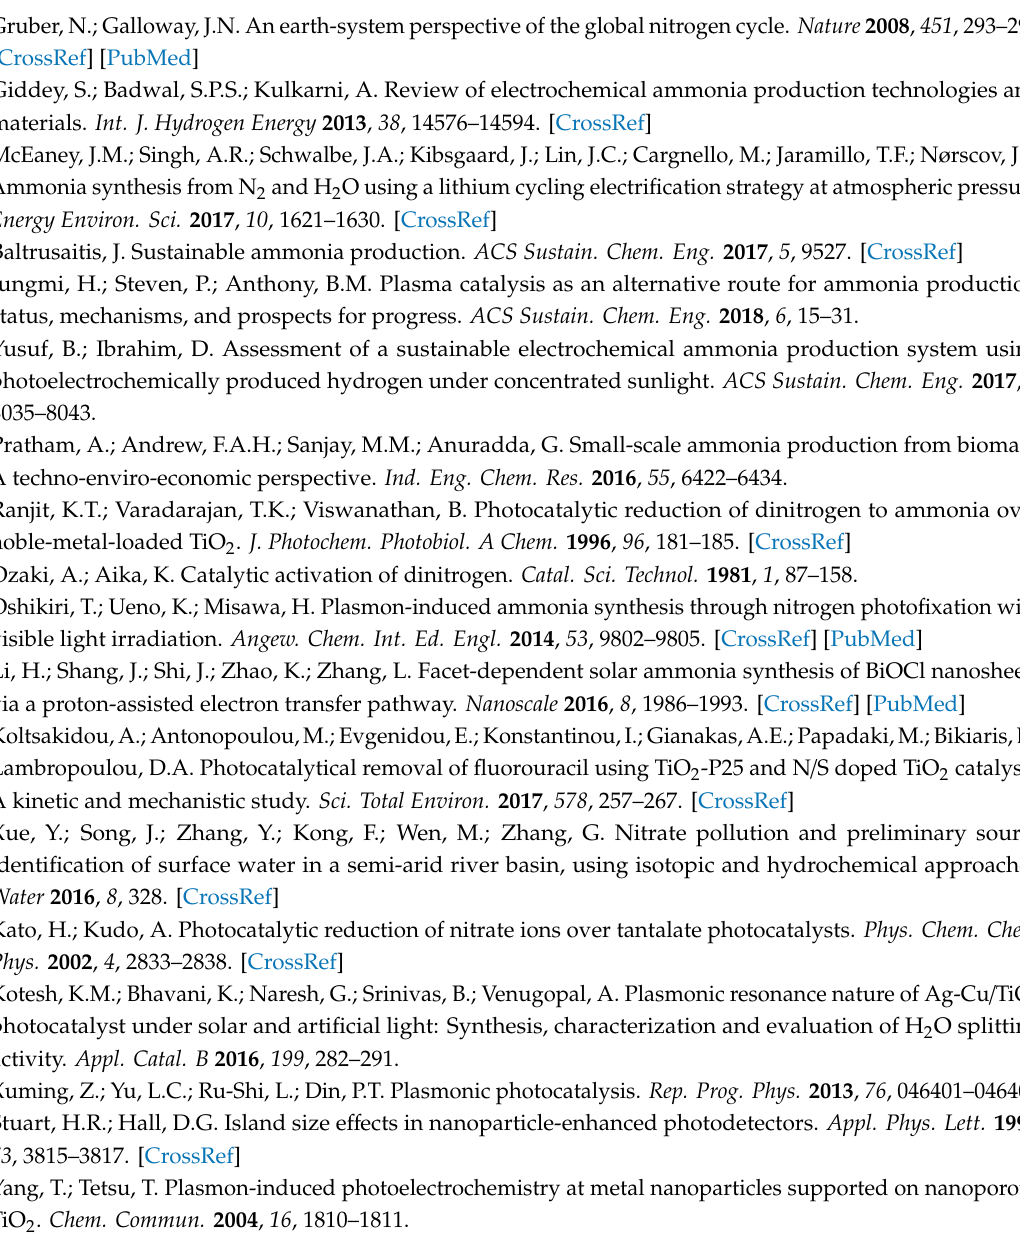
2 samples, Figure S5: Cu 2p core level spectra in TiO 2 samples, Figure S6: Ag 3d core level spectra in TiO 2 samples, and Figure S7: Oxidation of methanol to HCOOH during NO 3 − reduction under UV irradiation for 3